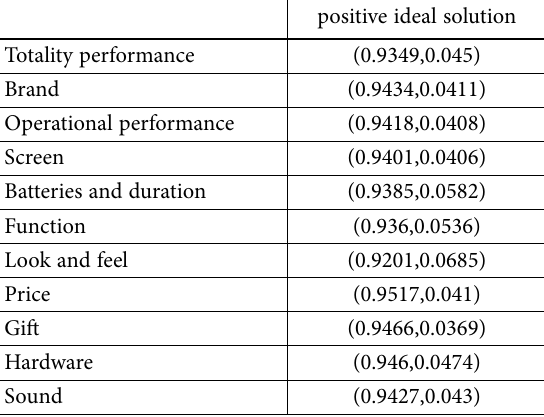
Table 15. The positive ideal solution